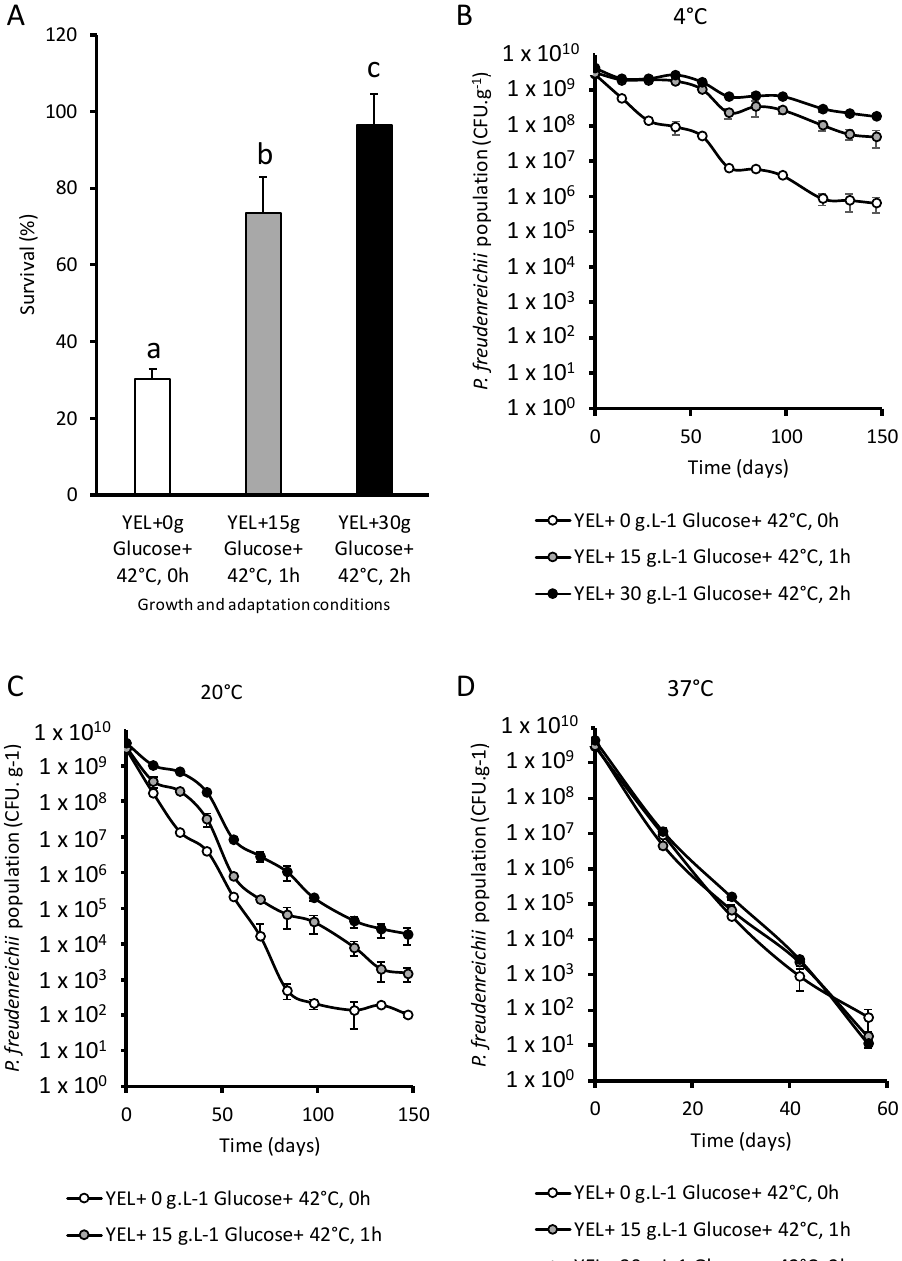
Figure 2. Glucose addition in growth medium and heat-adaptation improve P. freudenreichii viability during spray drying and storage. P. freudenreichii CIRM-BIA 129 were cultivated in YEL (YEL + 0 g Glucose + 42 ◦ C, 0 h), in YEL medium containing 15 g · L − 1 of glucose and heat-adapted at 42 ◦ C over 1 h (YEL + 15 g Glucose + 42 ◦ C, 1 h) or YEL medium containing 30 g · L − 1 of glucose and heat-adapted at 42 ◦ C over 2 h (YEL + 15 g Glucose + 42 ◦ C, 2 h) until the beginning of the stationary phase. Maltodextrine was added in the cultures with a final concentration of 20% ( w / w ) to increase the dry extract. Cultures were then spray dried ( A ) and P. freudenreichii survival was quantified by CFU counting as described in materials and methods. Results are expressed as percent survival. The different powders obtained were stored at 4 ◦ C ( B ), 20 ◦ C ( C ) and 37 ◦ C ( D ) over 145 days. P. freudenreichii viability was quantified by CFU counting during storage. Error bars represent the standard deviation for triplicate experiments. Significant differences are reported with different letters above the columns ( p > 0.05).